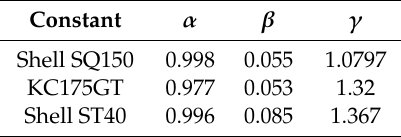
Table 2. Estimated values of the constants for the test PV